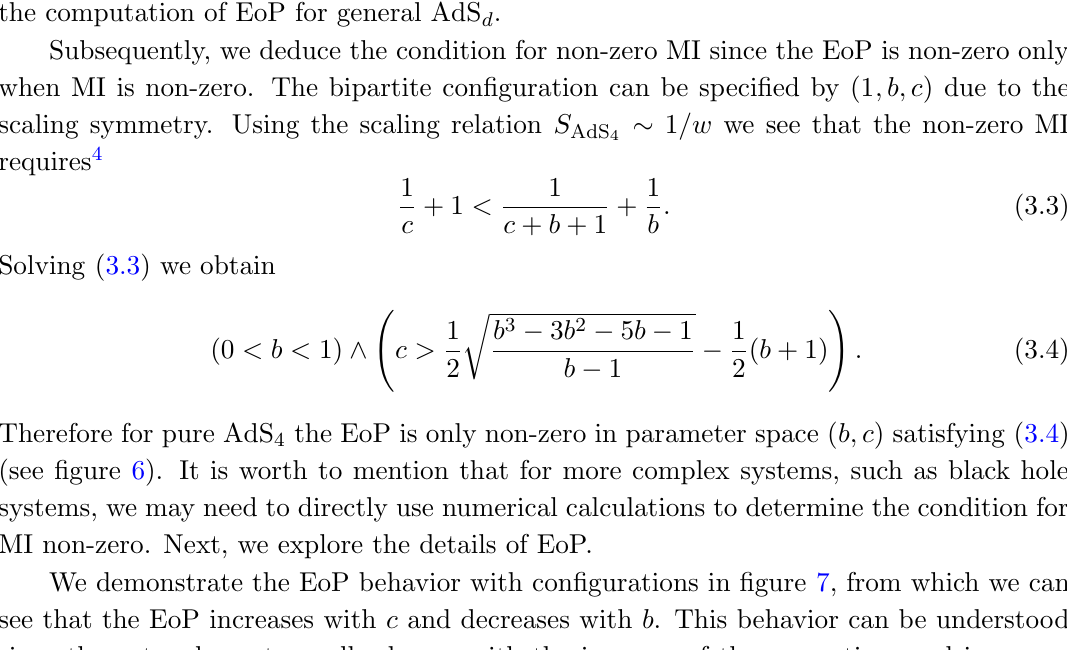
(cid:16) (cid:17) w 1 x z 1 , which matches perfectly with z 2 ( x w 1 w 2